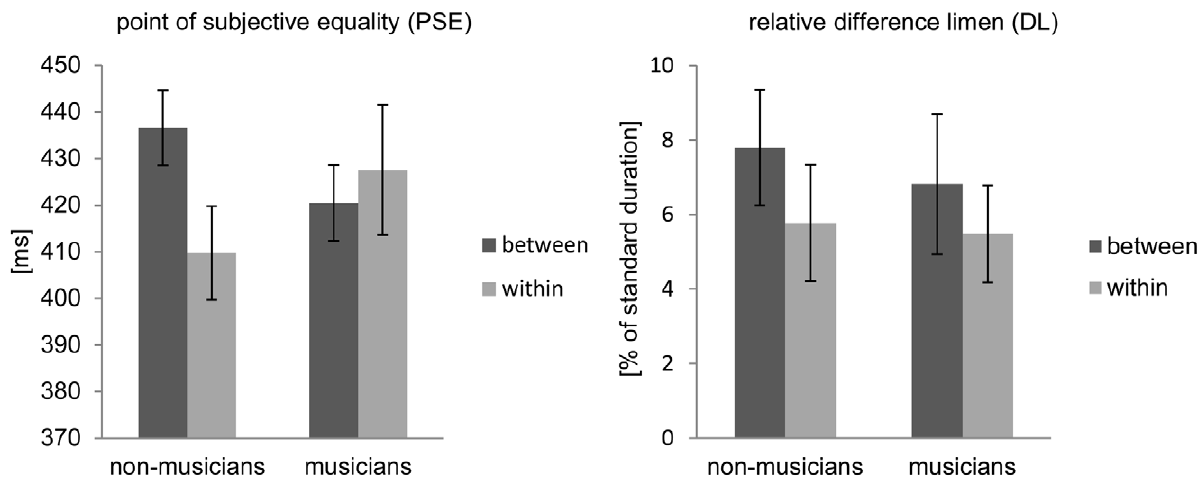
Figure 2. Behavioral consequences of rhythmic grouping perception. Absolute average point of subjective equality (PSE, left) and relative difference limen in percent of standard duration (DL, right). Data are plotted separately for musicians and musically untrained participants in the within and between temporal group conditions. Error bars indicate standard error. DL significantly differs between experimental condition (p , 0.01). On PSE groups of participants and experimental conditions interact (p , 0.01). PSE for musically untrained participants significantly differs between experimental conditions (p=0.01).